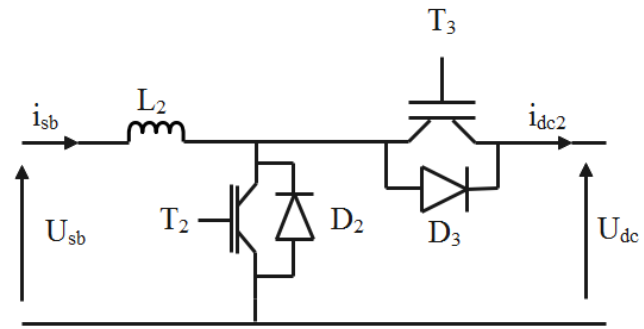
Figure 5. Bidirectional buck-boost chopper.